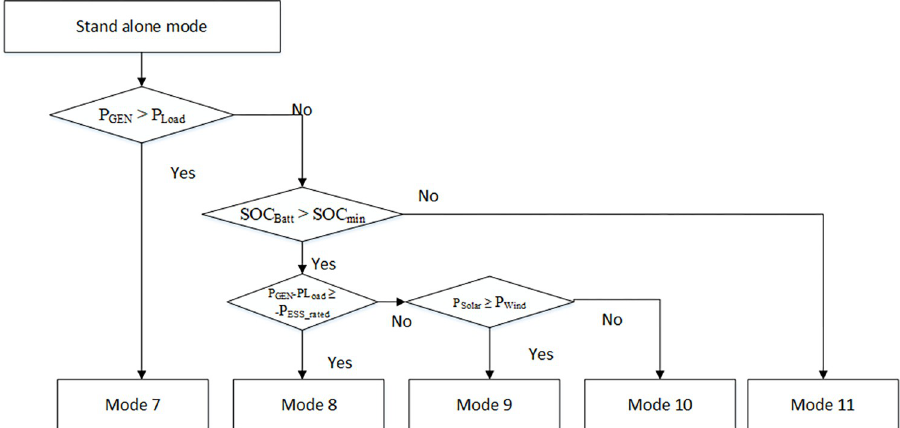
Fig 14. Flow chart of EMS for DC microgrid in standalone